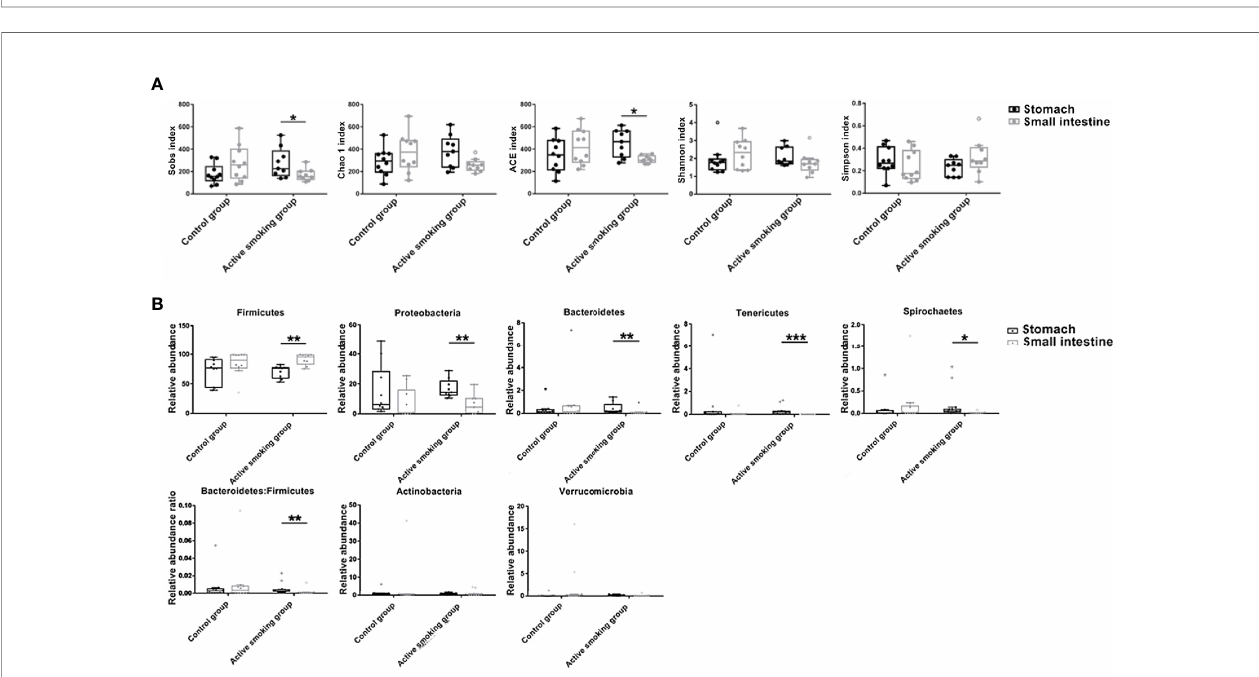
FIGURE 8 | Active smoking induced-differences in bacterial community structure and relative abundance between the stomach and small intestine. (A) Relative to the similarity in alpha diversity between two regions in the control group, signi fi cantly differential median Sobs and ACE were measured between the stomach and small intestine in the active smoking group. (B) Relative to the comparable relative abundances of bacterial phyla between the stomach and small intestine in the control group, signi fi cantly distinct relative abundances of bacterial phyla were determined in the active smoking group. *, ** and *** denote p < 0.05, p < 0.01 and p < 0.001, respectively.